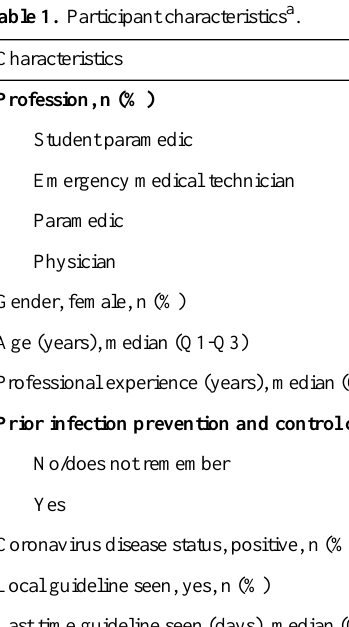
Table 1. Participant characteristics a .